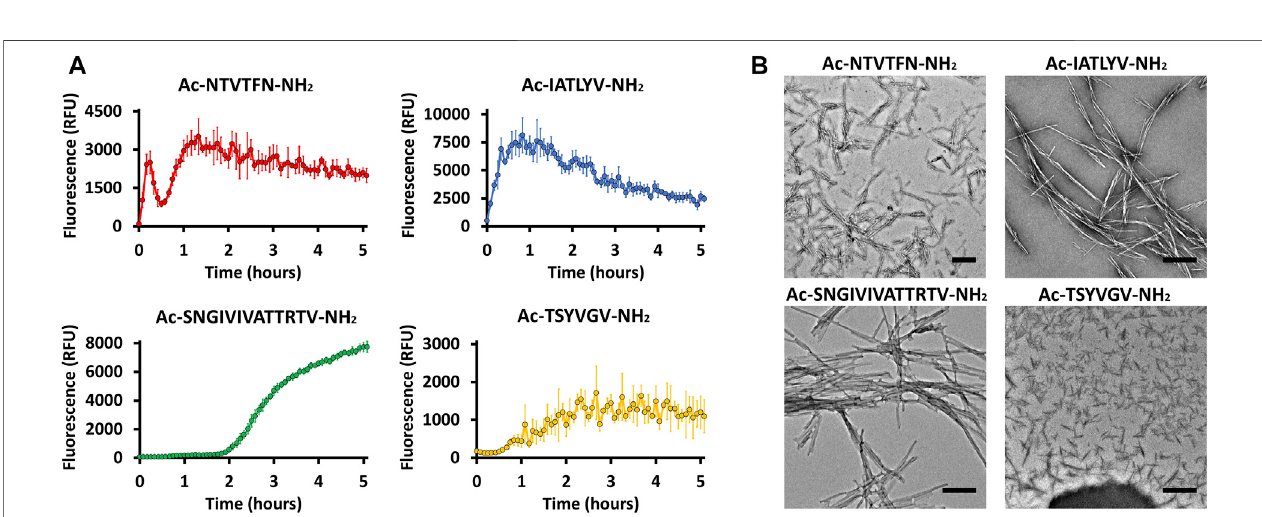
FIGURE 3 | Predicted segments exhibiting amyloidogenic properties (A) Segments for which the crystal structure was determined and 322 SNGIVIVATTRTV 334 show fi brillationwhen incubatedwithThT.Measurementswereconducted in50 mMTris-HClbuffer, 20 mMThT, and300 µMofpeptide.Thegraphshowstheaverage of three technical repeats, with error bars representing standard deviations. (B) Electron micrographs of the four segments show fi bril formation after 48 h of incubation. Scale bar represents 300 nm.